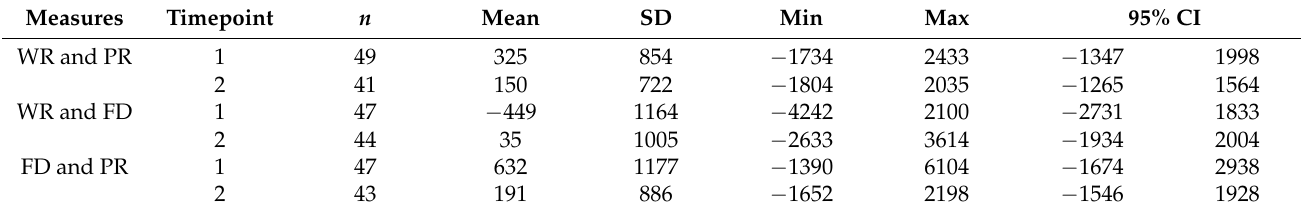
Table 7. Differences in estimated energy intake (kcal/day) between measures.